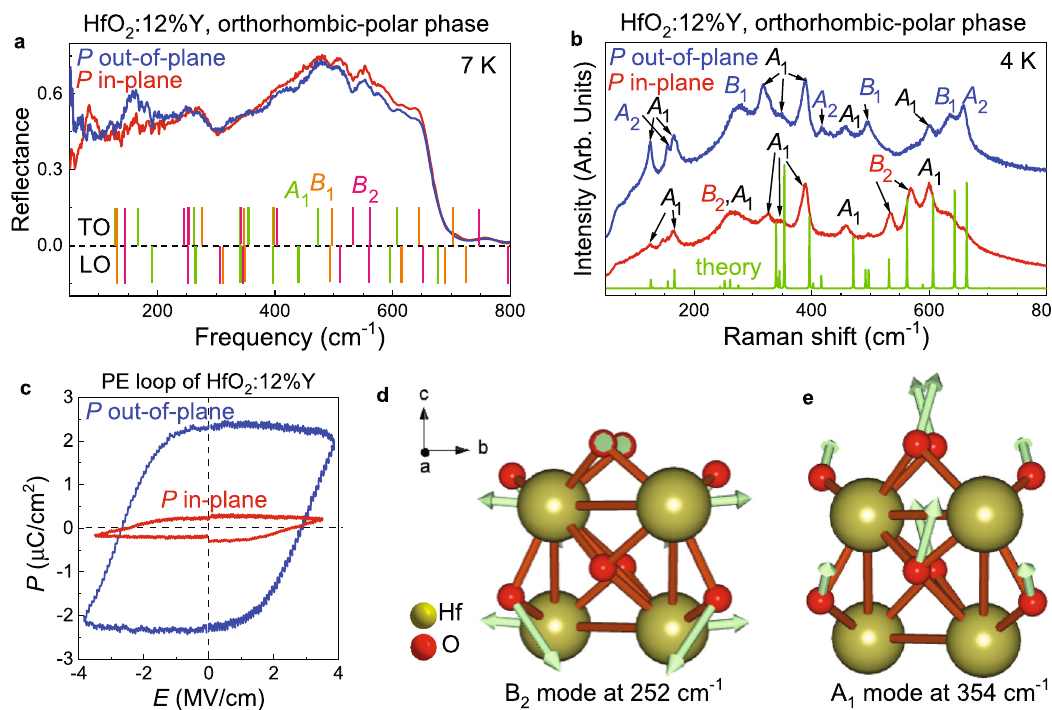
Fig. 3 Infrared and Raman responses of the orthorhombic-polar HfO 2 . a Infrared re fl ectance spectra of HfO 2 :12% Y for in- and out-of-plane ferroelectric polarization samples measured at 7 K, compared with the theoretically calculated infrared TO and LO peak positions in the pure o-III phase. b Raman spectra of HfO 2 :12% for the in- and out-of-plane polarization samples measured at 4 K, compared with the theoretically calculated Raman spectrum of the pure o-III phase. The measurement geometries are summarized in Table 1 and Supplementary Fig. 3. c Electric polarization hysteresis loops of the HfO 2 :12%Y. Red and blue colors refer to samples having ferroelectric polarization along the in- and out-of-plane surface directions, respectively. d , e Calculated phonon displacement patterns for the 252 cm − 1 (theory) Hf-Hf breathing mode and the signature polar mode of the o-III phase at 354 cm − 1 (theory). Animations are available in the Supplementary Note